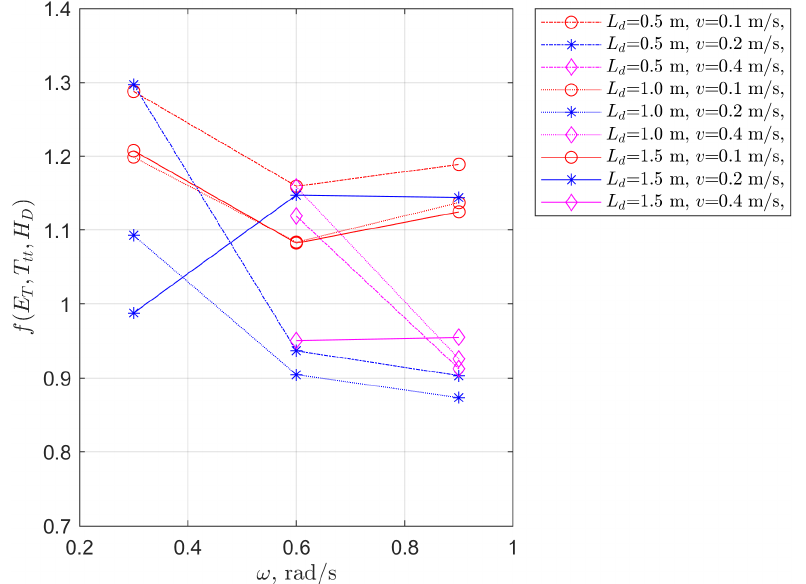
Figure 7. Cost function vs. angular rate for selected maximum values of the linear speed and look ahead distance—track 1.